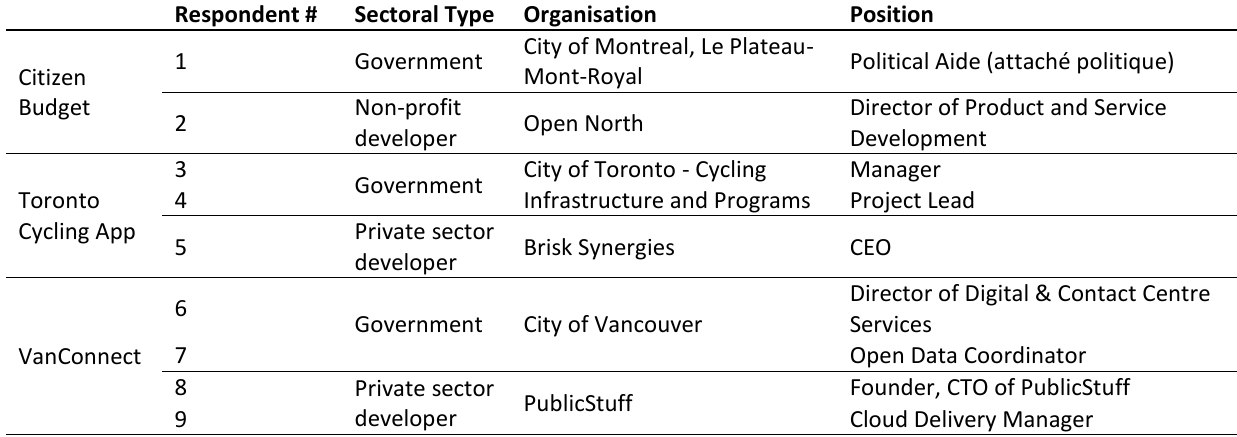
Table 3. List of